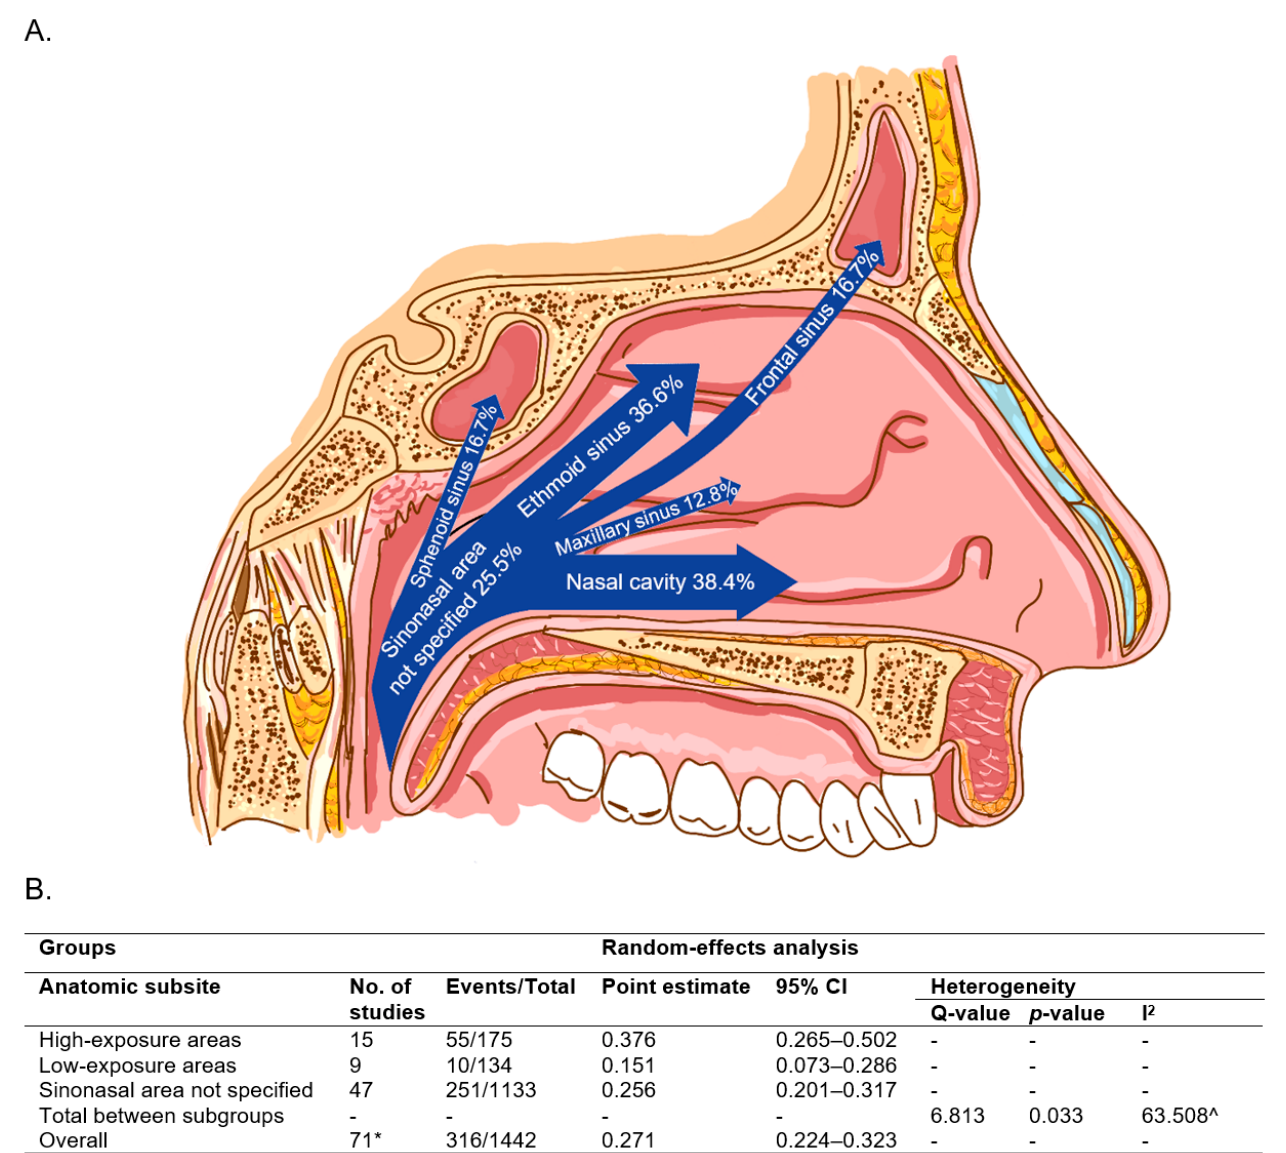
Figure 2. HPV prevalence distribution by sinonasal anatomic subsite. ( A ). Sagittal section of the nasal cavity with arrows displaying the entry and distribution of HPV prevalence estimates by anatomic subsite using the random-effects model. ( B ). HPV prevalence estimates stratified by high- and low-exposure anatomic subsites. * With multiple subgroups in one study, Comprehensive Meta-Analysis (CMA) program will see each subgroup as a separate study. Hence, a total of 71 studies here. ^ Only calculated using the fixed-effects model.